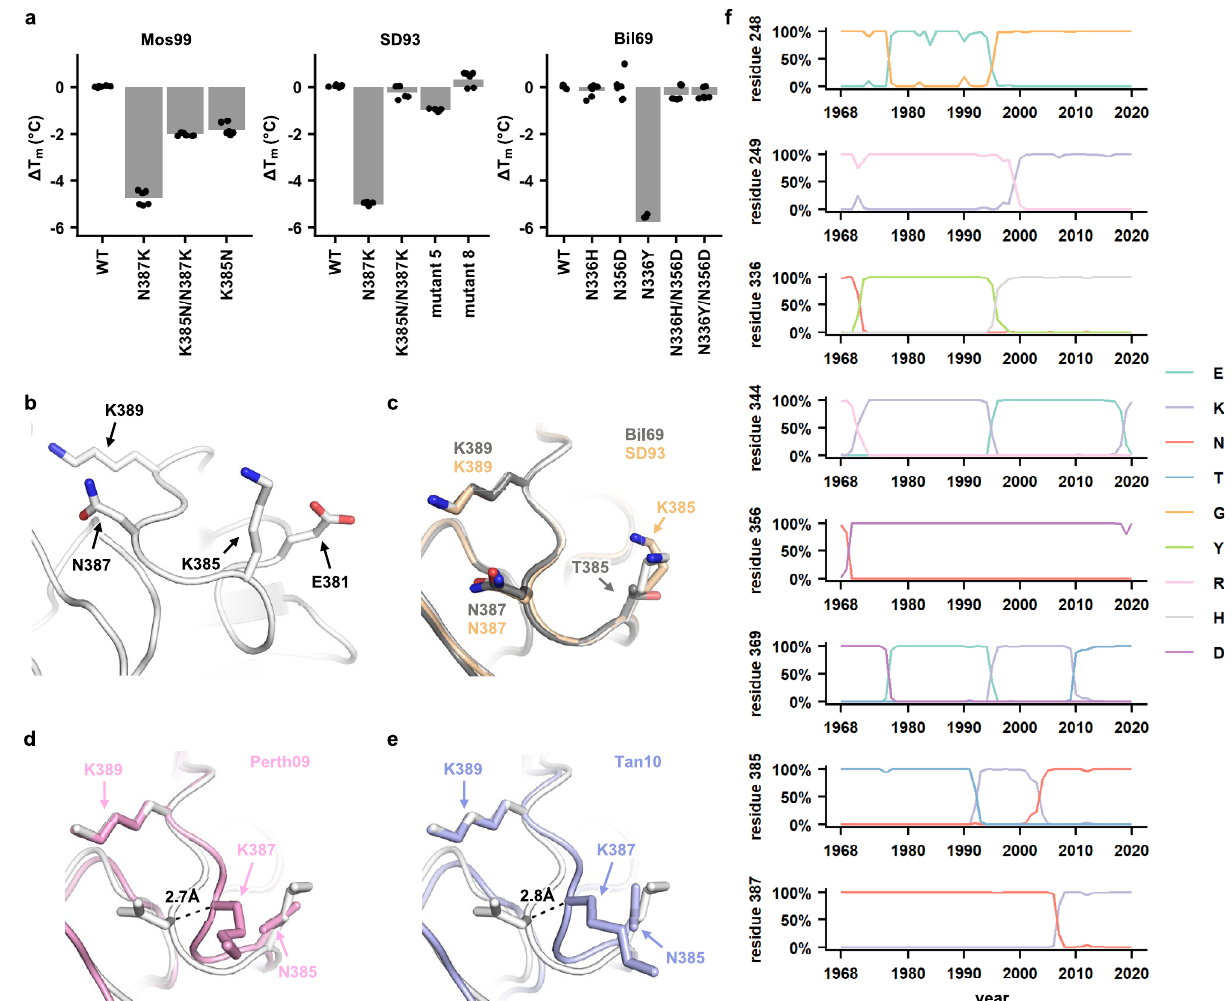
Fig. 6 | Structureand stabilityofH3N2 neuraminidase.a The effectsofdifferent Mos99, SD93, and Bil69 NA mutants on protein melting temperature ( T m ) were measured by thermal shift assay. Eachbar represents the mean of six independent biological replicates. Each datapoint represents one biological replicate. Jittering wasaddedtoavoidoverlapofdatapoints. b Thelocationsoftheresiduesofinterest on Mos99 NA are shown. c – e The local structure around residue 387 of Mos99 NA